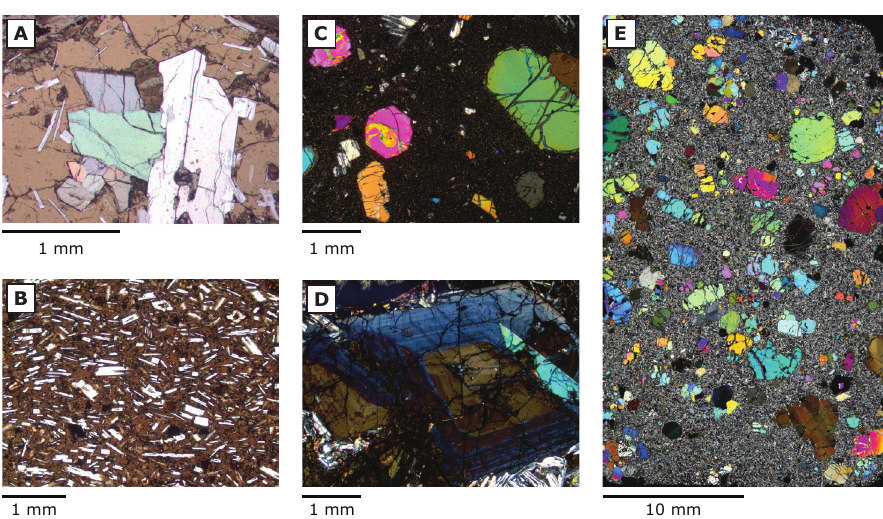
Figure 4. Petrographic variation in alkali basalt lava flows displayed in photomicrographs. [A] Olivine and plagioclase phenocrysts in a glass matrix with smaller plagioclase microcrysts at Site U1372 (sample 330-U1372A-18R-3, 14–16 cm; cross-polarized light). [B] Aphyric basalt showing glassy groundmass, small unaltered groundmass olivine, and flow-aligned plagioclase laths at Site U1374 (sample 330-U1374A-19R-1, 50–53 cm; plane-polarized light). [C] Highly olivine-titanaugite-plagioclase-phyric basalt from a clast in a conglomerate of the sediment cover at Site U1373 (sample 330-U1373A-1R-2, 123–125 cm; cross-polarized light). [D] Ti-augite phenocryst in highly olivine-augite-phyric basalt at Site U1373 (sample 330-U1373A-7R-1, 84–86 cm; cross-polarized light). [E] Highly